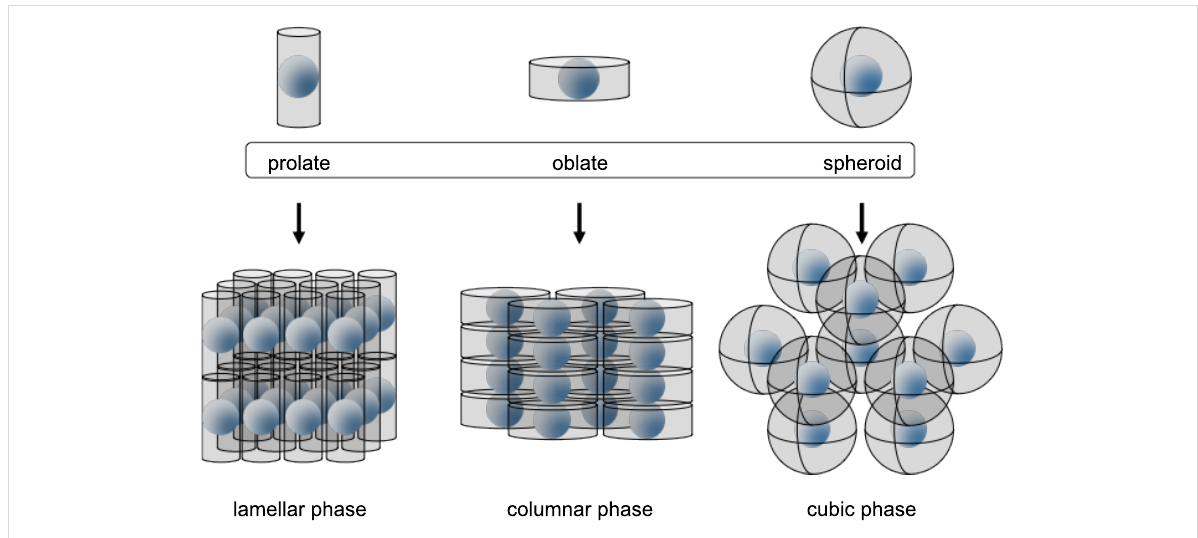
Figure 27: Some of the various hybrid geometries and packing motifs possible upon ligand grafting to the surface of a pseudospherical NP. The role of the ligand(s) in migrating and deforming at the surface is crucial in providing these structures.